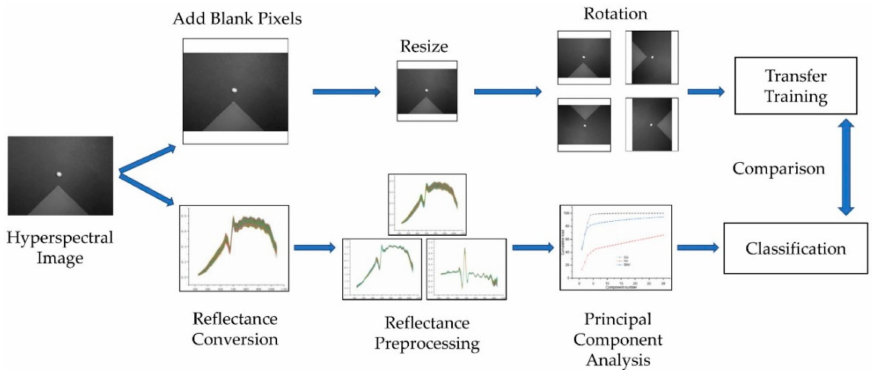
Figure 8. Technical